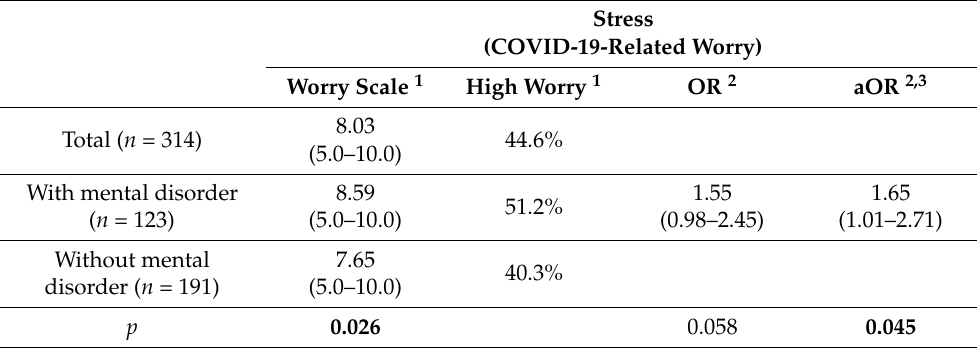
Table 2. Comparison of COVID-19-related worry scores as a measure of stress between participants with and without existing mental